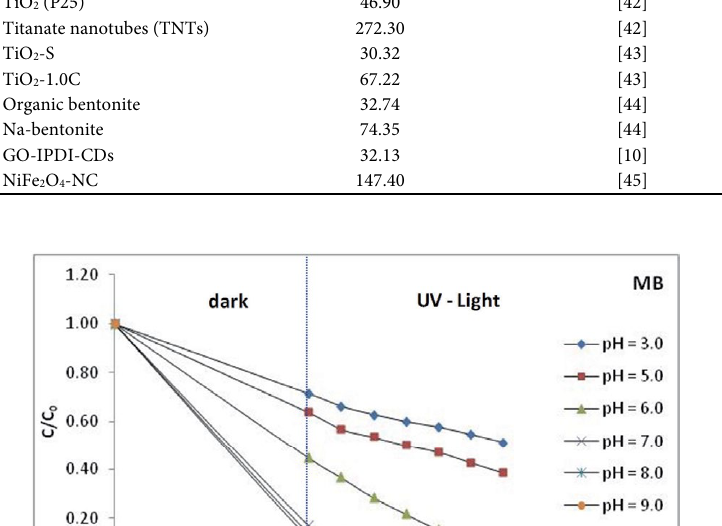
Table 2. Specific surface area of TiO 2 -Gly- β CD with other samples.